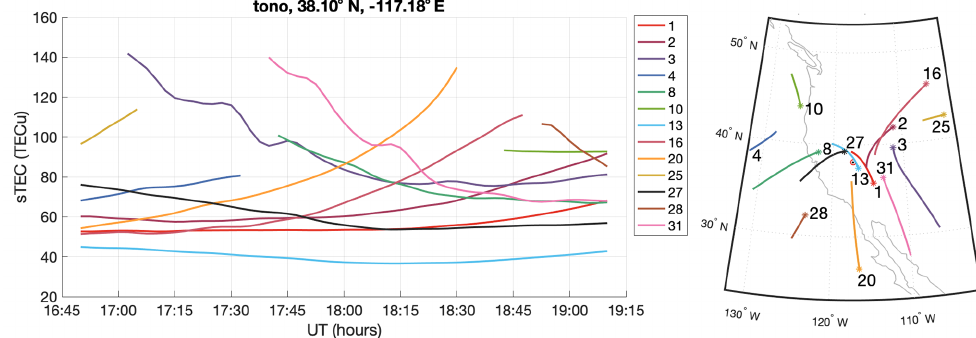
Figure 3. Biased sTEC from GPS receiver station tono on 31 October